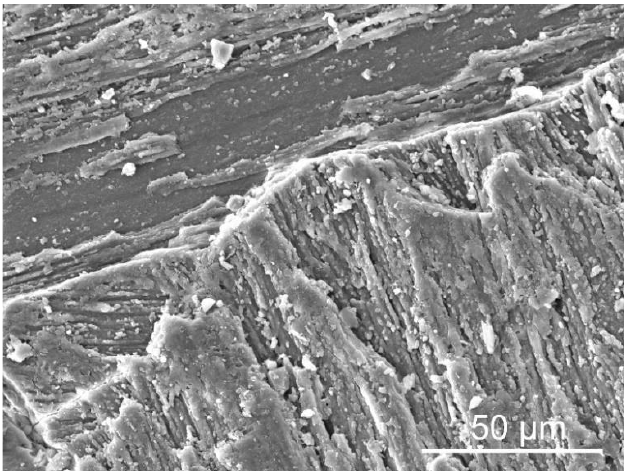
Figure 8. Plywood structure in Sphenothallus sp. from the Carboniferous of